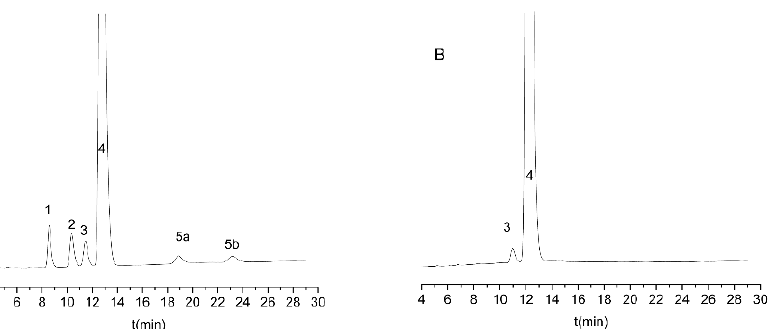
Figure 4. Representative chromatograms obtained during method optimization and